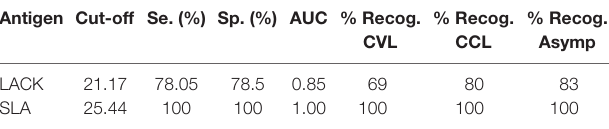
TaBle 1 | Percentage of individuals with immune cellular memory against L. infantum who recognized Leishmania -activated C-kinase antigen and soluble Leishmania antigen